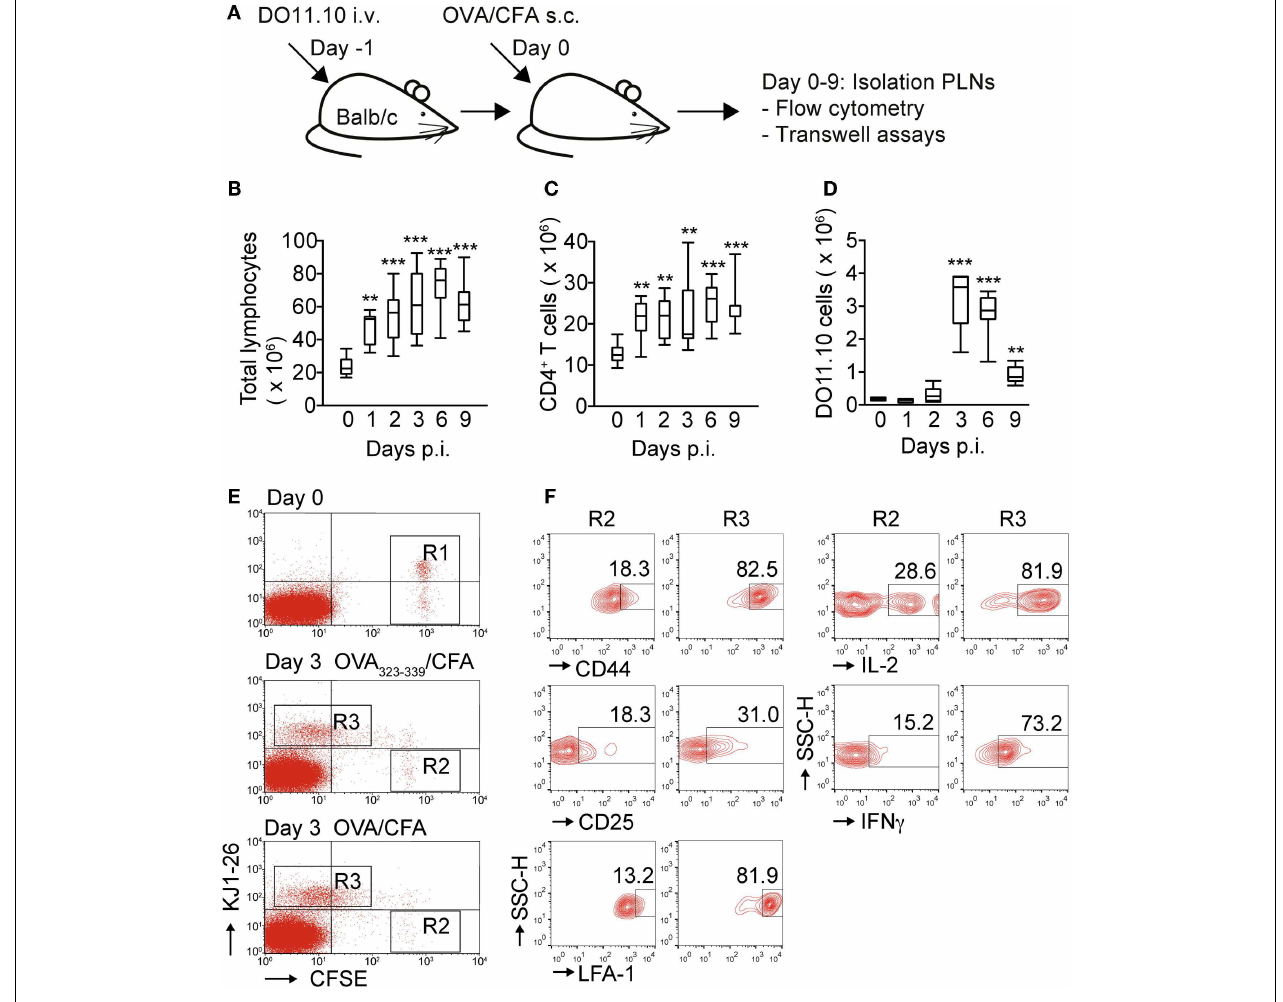
(bottom panel) immunization (R2 and R3, respectively). (F) Flow cytometry analysis of activation markers of KJ1–26 (cid:0) and KJ1–26 + cells in gates R2 and R3 as shown in (E) after priming with peptide. Similar results were obtained with OVA immunization. Numbers indicate percentages in gated populations. Data in (B–D) are pooled from 6 independent experiments combining 4–13 mice/time point and are shown as box and whiskers graphs as described in the section “Materials and Methods.” Flow cytometry plots in (E,F) are representative of two independent experiments. Statistical analysis was performed using ANOVA test against “Day 0” values followed by Dunnett’s multiple comparison test. ** p < 0.01; *** p <